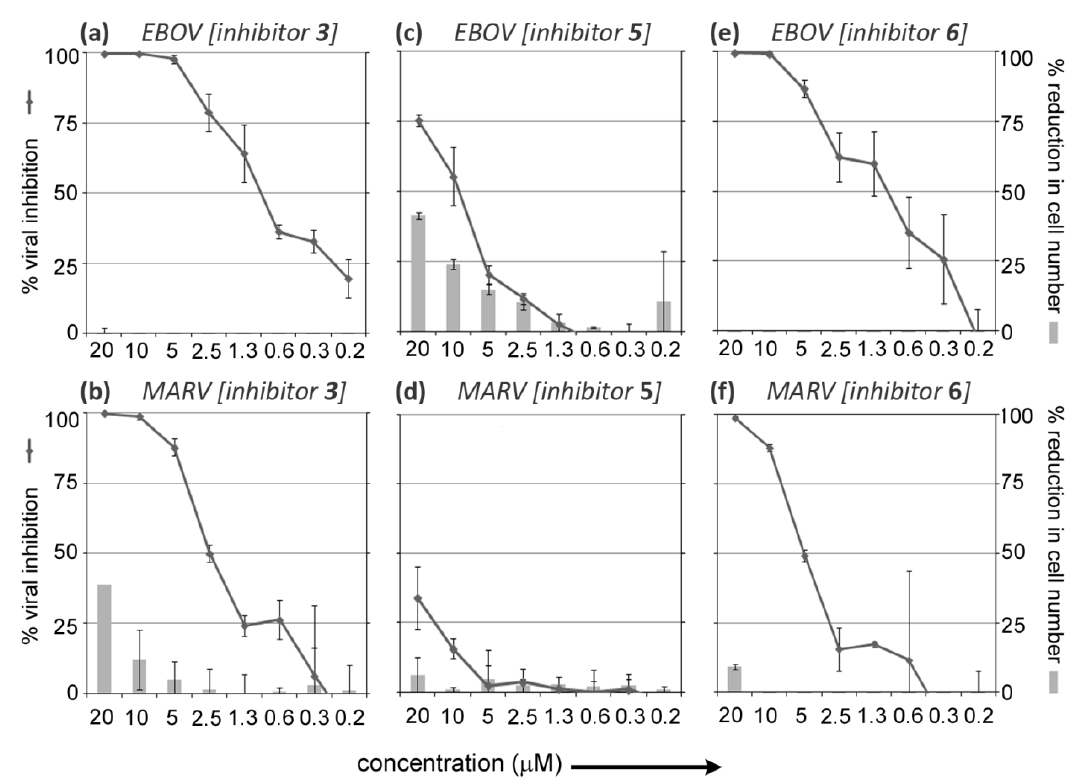
Figure 2. Dose - response curves: the inhibitory efficacies and cellular toxicities (based on reduction in cell number in compound treated and infected samples versus DMSO only treated and infected controls) of 3 , 5 , and 6 at eight concentrations during Ebola (EBOV; Zaire-95 isolate) and Marburg (MARV; Ci67 isolate) infection. ( a ) Dose-response curve for 3 (both cellular protection and toxicity) during EBOV infection; ( b ) Dose-response curve for 3 (both cellular protection and toxicity) during MARV infection; ( c ) Dose- response curve for 5 (both cellular protection and toxicity) during EBOV infection; ( d ) Dose-response curve for 5 (both cellular protection and toxicity) during MARV infection; ( e ) Dose-response curve for 6 (both cellular protection and toxicity) during EBOV infection; ( f ) Dose-response curve for 6 (both cellular protection and toxicity) during MARV